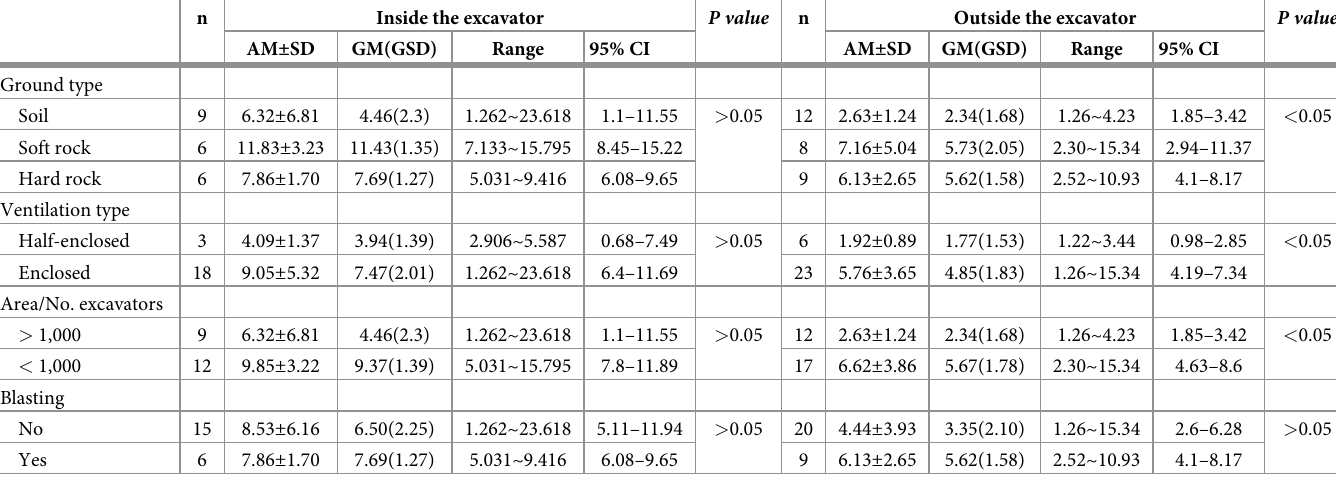
Table 5. Concentration of PAHs by environmental variables (unit: μ g/m 3